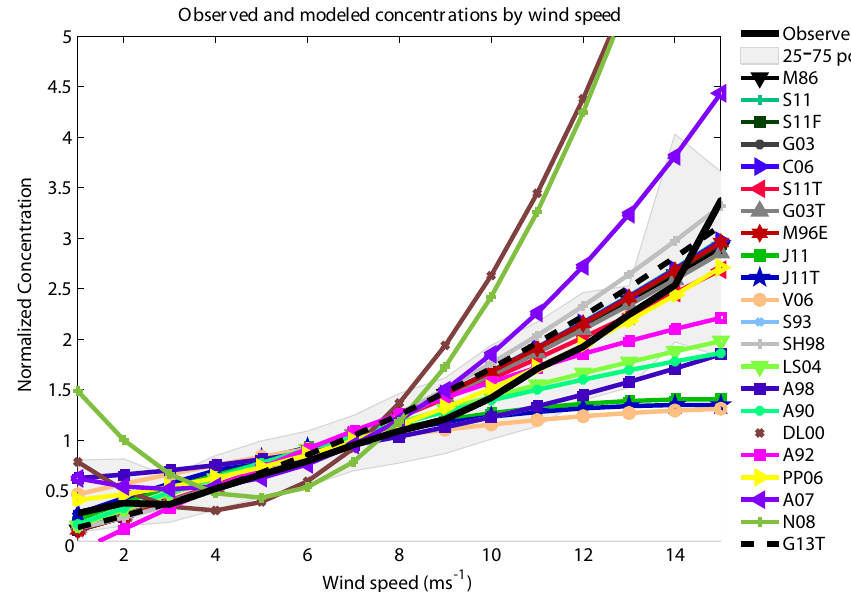
Fig. 9. Median-normalized measured and modeled SSA concentrations as a function of source-region average wind speed. Observations are shown by a black solid line with the grey shaded area giving the 25–75% range. Colored lines are modeled values (for acronyms in the legend, see Table 1) approximated with a second-order polynomial